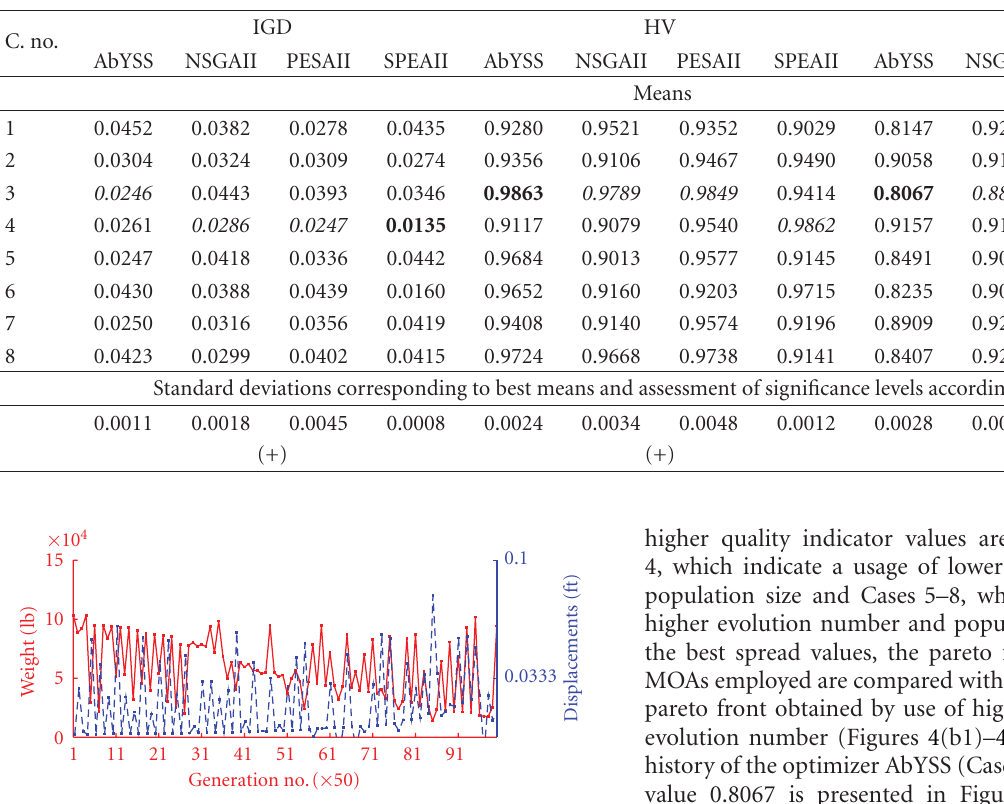
Figure 9: Convergence history obtained by AbYSS (Case